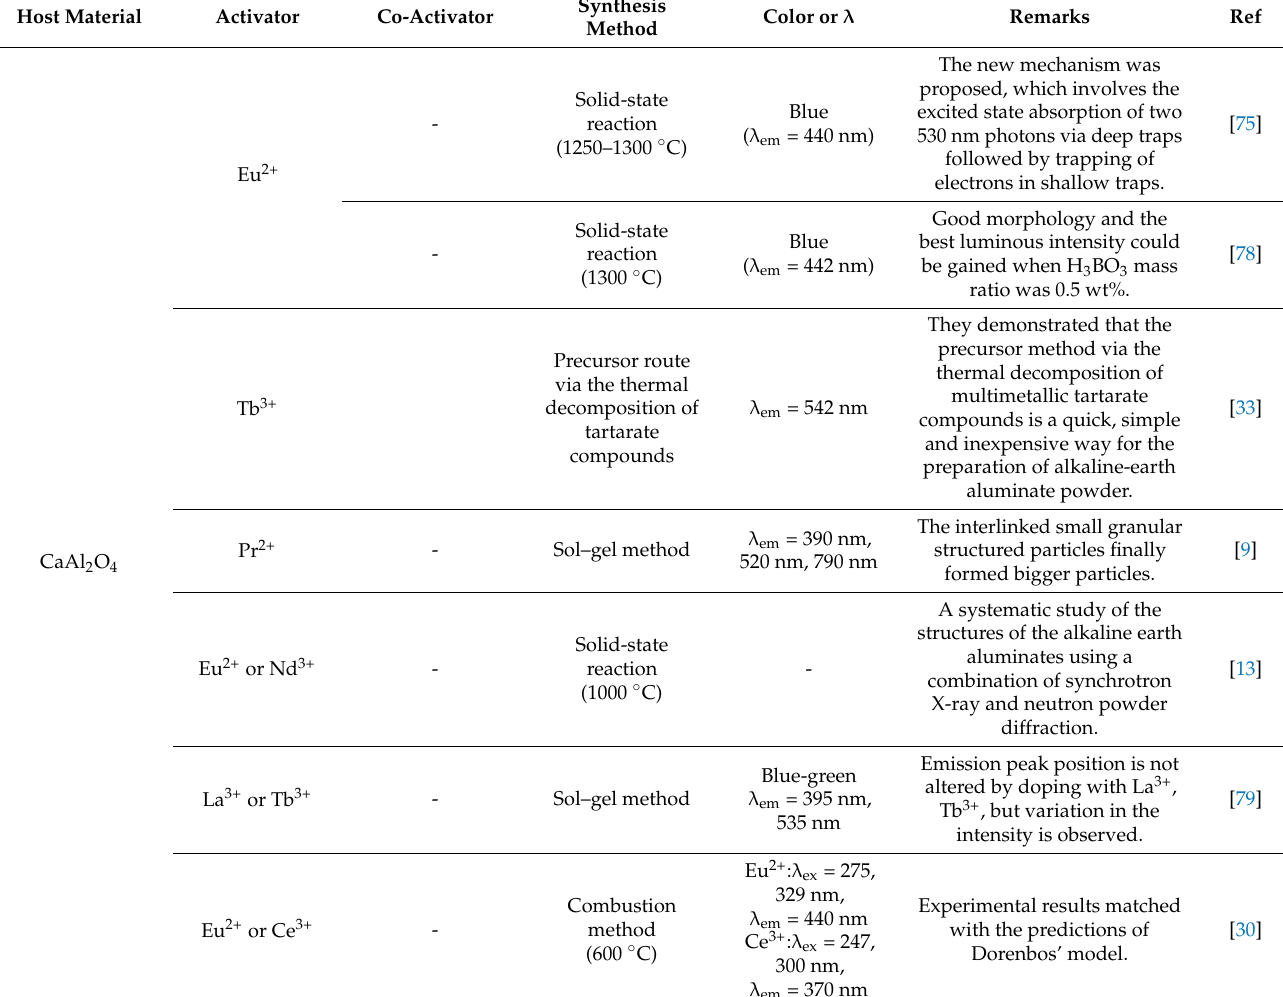
Table 2. Comparison of reported studies for the synthesis of lanthanide-doped calcium aluminate phosphors. Host